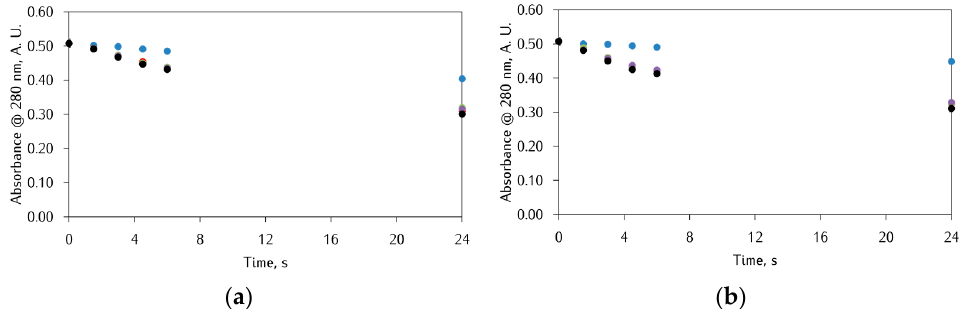
Figure 5. ( a ) Kinetic traces of 200 µM DA in Mops bu ff er pH 7.0 and 37 °C (blue) in the presence of 10 µM of Fe II (red) and 2 equiv. of peptide (Ac- α S 119–132 : green, Ac- α S p S 119–13 : purple, Ac- α S p Y p S 119–132 : black). ( b ) Kinetic traces of 200 µM DA in Mops bu ff er pH 7.0, SDS 20 mM, 37 °C (blue) in the presence of 10 µM of Fe II (red) and 2 equiv. of peptide (Ac- α S 119–132 : green, Ac- α S p S 119–13 : black).